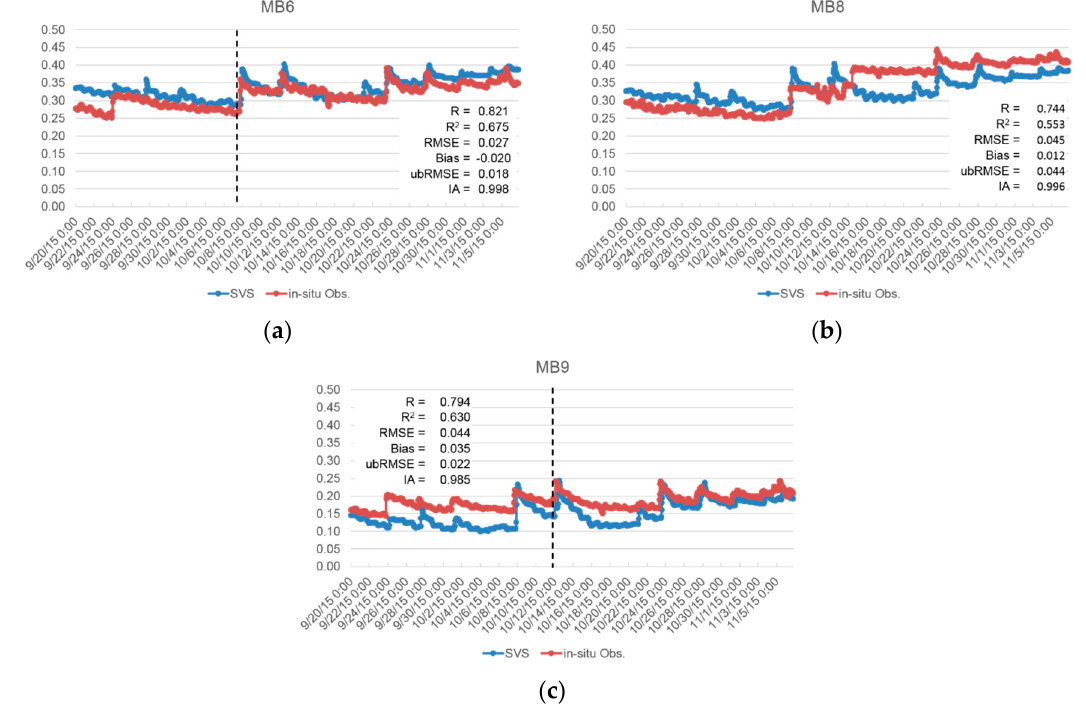
Figure 6. Time series of hourly averaged surface soil moisture for SVS compared with observations from the ( a ) MB6, ( b ) MB8, and ( c ) MB9 RISMA stations. Vertical dashed lines in ( a , c ) indicate the simulated and observed soil moisture on 7 October and 12 October, respectively.